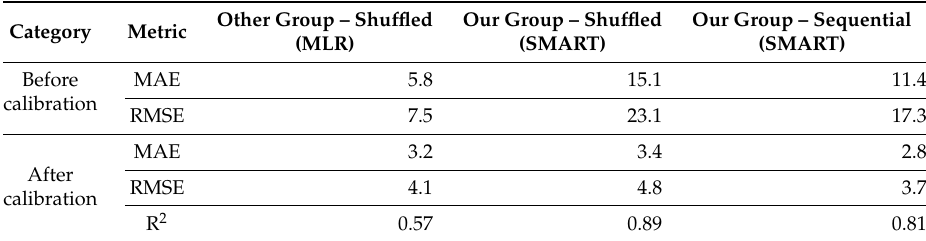
Table 9. Performance comparison by group &